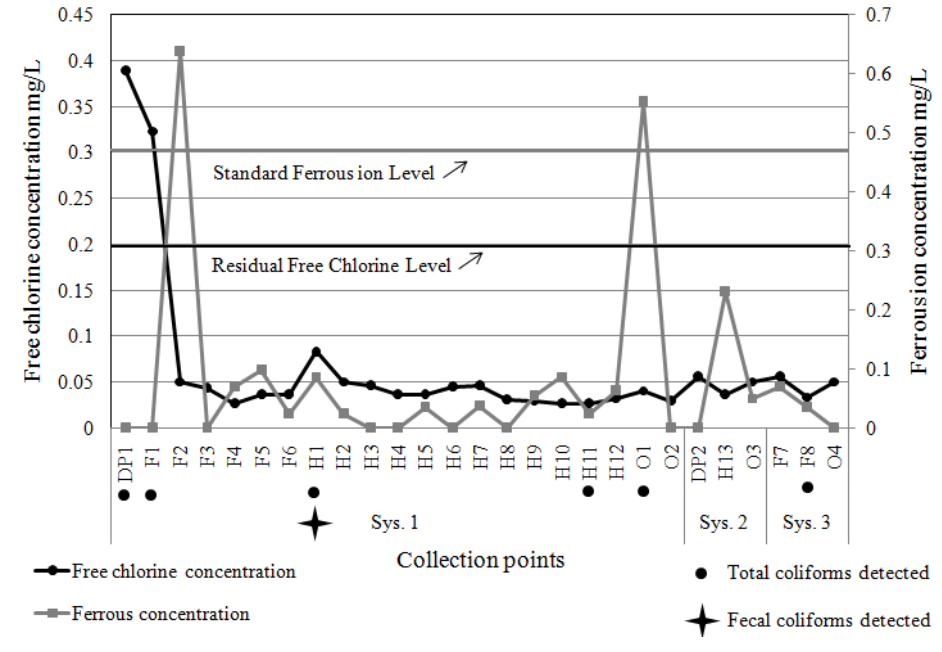
Figure 4: Average free chlorine, ferrous ion concentrations, and the presence of total and fecal coliforms in different samples from the three water distribution systems. Each data point is an average of 3 trials carried out at different times. (n=27). DP – Distribution points, F– Faculties of study, H – Halls of residence, O – Other points System 1 – Meewathura System, 2 – near the University Piggery, System 3 – at Gatambe [Kandy Municipal